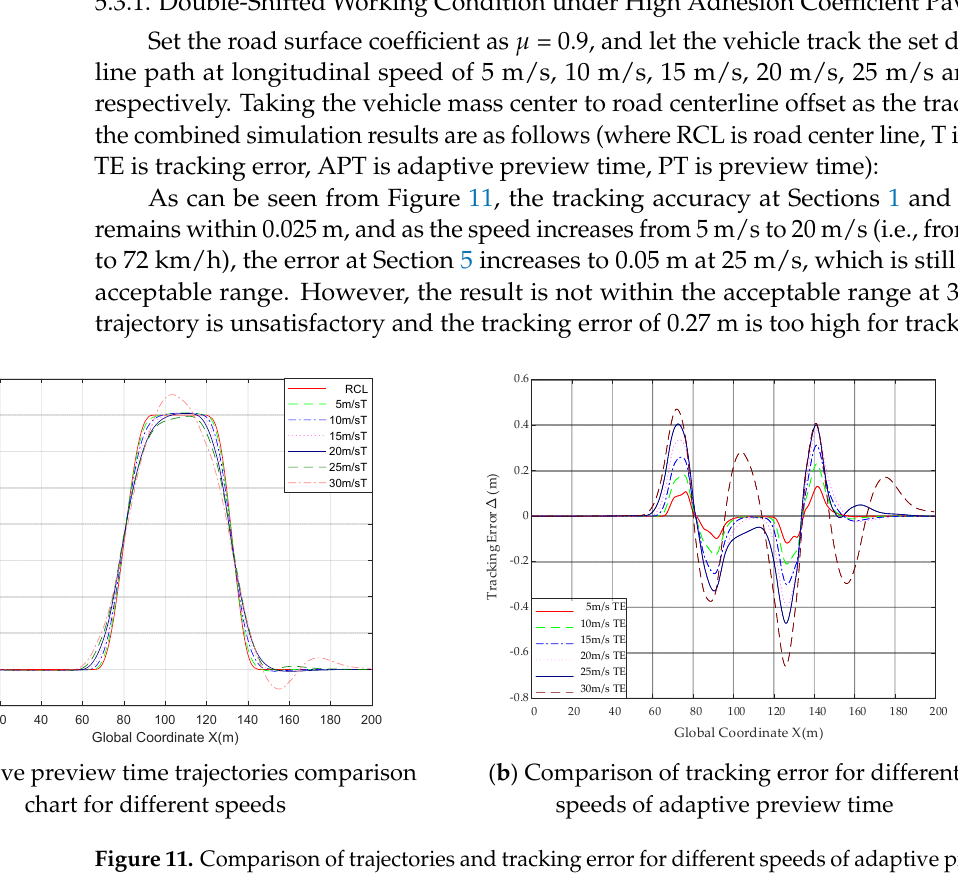
− 1.4423 ( a ) Comparison of trajectories at 5 m/s with different preview times ( b ) Comparison of tracking error at 5 m/s with dif ‐ ferent preview time Figure 12. Comparison of trajectories and tracking error with different preview times at 5 m/s.